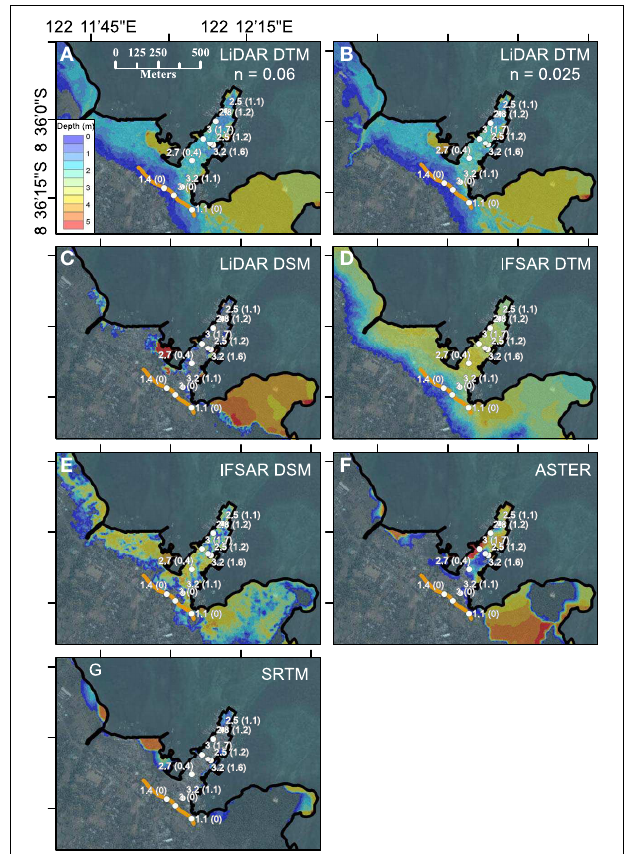
FIGURE 7 | Comparison between inundation limit from georeferenced observational sketch from Tsuji et al. (1995) (orange line) and ANUGA inundation models for Wuring Peninsula, Flores, for (A) benchmark model using LiDAR DTM ( n = 0 . 06 ); and comparison models ( n = 0 . 025 ) for (B) LiDAR DTM; (C) LiDAR DSM; (D) IFSAR DTM; (E) IFSAR DSM; (F) ASTER; and (G) SRTM. Mesh resolution is 7.62m. White figures show tsunami heights in meters from Tsuji et al. (1995) observations with tsunami flow depths in parentheses.